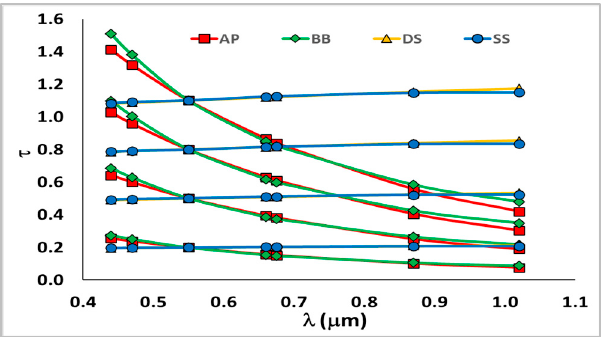
Figure 1. The simulated spectral aerosol optical depths (AODs) at 0.44, 0.47, 0.55, 0.66, 0.675, 0.87, and 1.02 µm for anthropogenic pollutant (AP, red), biomass burning (BB, green), dust (DS, yellow), and sea salt (SS, blue) under initial AOD 0.55µm values of 0.2, 0.5, 0.8, and 1.1 from the second simula- tion of a satellite signal in solar spectrum (6S) radiative transfer model with the experimental da-